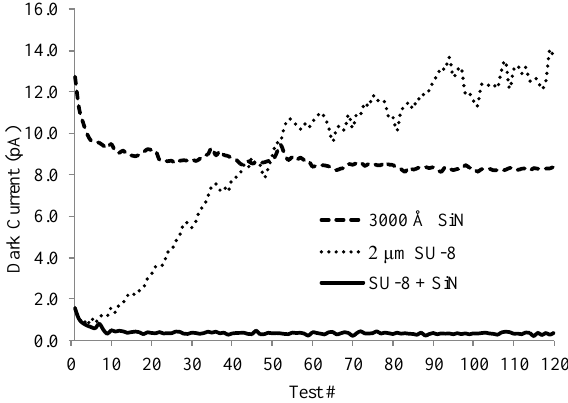
Figure 6. Dark current vs. test number for three different photodiode passivation schemes. The time interval between tests was not consistent due to the low current of the diodes and the charge integration time required to measure the current.